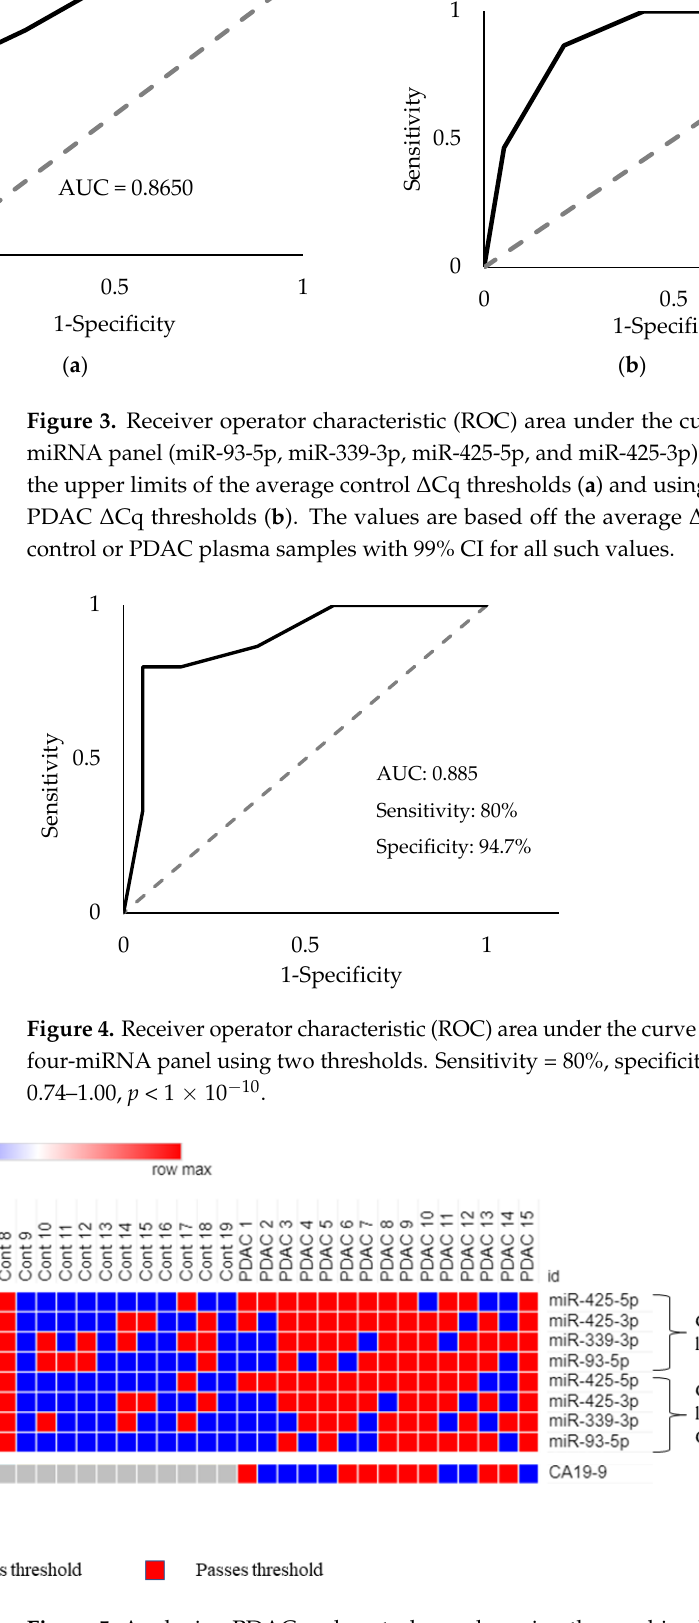
Figure 5. Analyzing PDAC and control samples using the combined four-miRNA biomarker panel. The heatmap shows which samples surpassed the two thresholds (ΔCq is greater than the upper limit of the control for each miRNA AND ΔCq is greater than the lower limit of PDAC for each miRNA, 99% CI), indicating a positive hit for PDAC. Red indicates a positive hit and blue indicates a negative hit. Columns labeled as “ Cont ” represent control plasma samples while columns labeled as “PDAC” represent plasma from patients with pancreatic cancer. PDAC 1, 2, 3, 4, and 5 represent early-stage (I and II) pancreatic cancer; PDAC 6, 7, and 12 represent mid-stage (stage III) pancreatic cancer; and PDAC 8, 9, 10, 11, 13, 14, and 15 represent late-stage (stage IV) pancreatic cancer. CA19- 9 values are added for comparison where the threshold is the medically established value of > 37 U/mL. 3. Discussion Pancreatic cancer continues to be a difficult disease to diagnose and treat. Mortality rates for PDAC are high, though each year has brought marginal improvements in survival rate, with 2022 reporting a survival rate of 11% [1]. The need to develop more reliable methods of detecting pancreatic cancer at earlier stages remains a top priority. Some avenues of research have turned to freely circulating miRNAs or exosomal miRNAs for an array of diseases, including various cancers [28]. Recently, a study by Zou et al. proposed a panel for the early detection of PDAC comprising six circulating miRNAs (let- 7b-5p, miR-192-5p, miR-19a-3p, miR-19b-3p, miR-223-3p, and miR-25-3p) that were identified by machine learning and validated in patient samples [29]. Another study by Wang et al. discovered a single serum exosomal marker, miR-1226-3p, that could diagnose and predict pancreatic cancer invasion and metastases [30]. Despite these important contributions, there remain alternative diagnostic biomarkers to be discovered with the potential for earlier and more reliable detection of pancreatic cancer. Our previous study identified 18 candidate miRNAs from a bioinformatics analysis of publicly available cBioPortal data collected from pancreatic cancer patients [23]. Seven miRNAs were verified to be differentially expressed in exosomes collected from PDAC cell lines compared to an immortalized pancreatic cell line in vitro. Therefore, we sought to validate the expression levels of these candidate miRNAs in plasma exosomes collected from known PDAC patients. The present study identified four miRNAs, miR-93-5p, miR- 339-3p, miR-425-5p, and miR-425-3p, with significantly greater ΔCq values in PDAC plasma samples compared to control plasma samples. A biomarker panel consisting of these four miRNAs and a dual threshold cutoff consisting of the upper limit of the ΔCq values (99% CI) of the miRNAs from control samples and the lower limit of the ΔCq values of the miRNAs (99% CI) from PDAC samples resulted in a diagnostic with an AUC of 0.887, a sensitivity of 80%, and specificity of 94.7%. This is comparable to the current FDA-